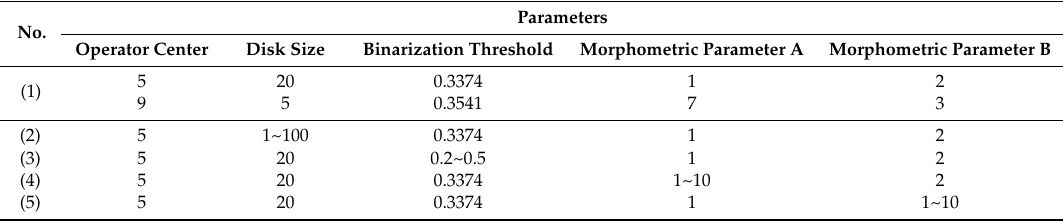
Table 2. Parameters of experiments No. 1 to No.